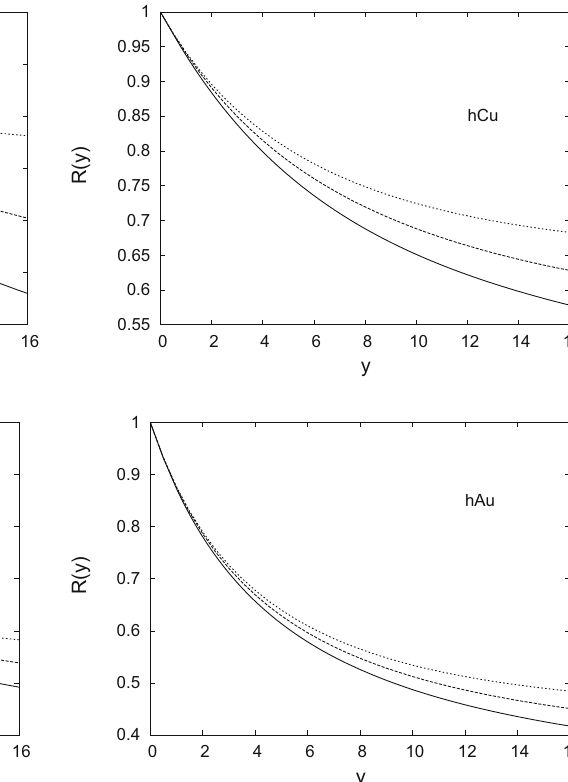
tering on aluminium (upper left), copper (upper right), silver (bottom left) and gold (bottom right). In all cases μ 0 = 0 . 12, μ 2 = − 0 . 0531, ¯ α = 0 . s